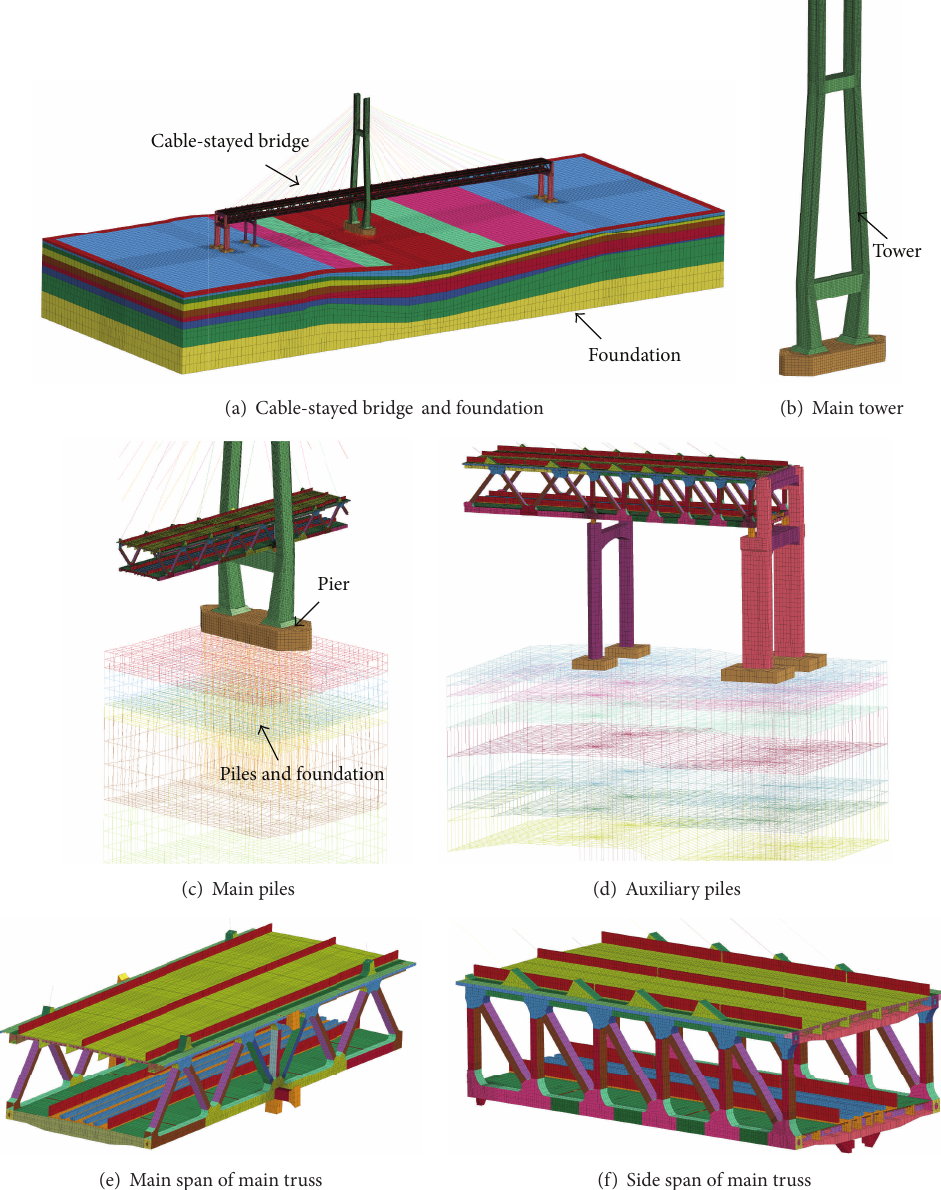
Figure 2: Finite element model of cable-stayed bridge and